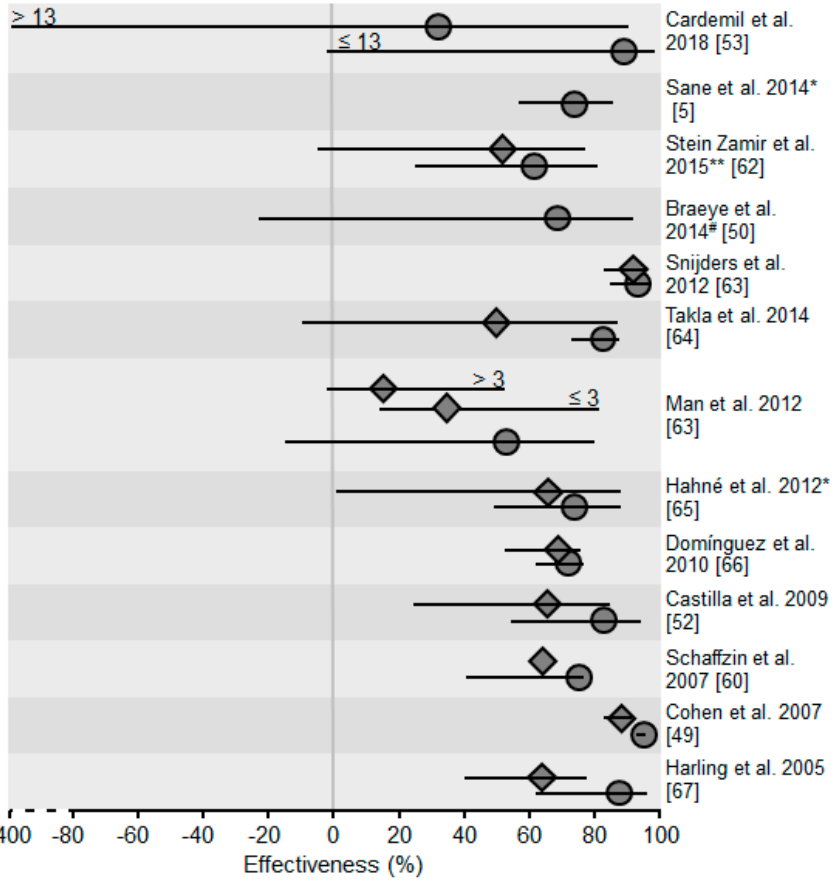
Figure 2. Vaccination effectiveness (%) after MMR-vaccination in published analyses. Studies were obtained by performing a “Pubmed” request [42] using the search terms “mumps” and “vaccination effectiveness” and “outbreak”. Data were accessed on 29 March 2018. Rhombuses: Effectiveness after 1 MMR dose. Circles: Effectiveness after 2 doses. Lines: 95%-Confidence intervalls. >13 = Effectiveness when second vaccine dose was >13 years ago. ≤ 13 = Effectiveness when second vaccine dose was ≤ 13 years ago. * / **: Effectiveness against orchitis * or other complcations **. # : Effectiveness of 2 doses vs. 1 dose. ≤ 3 = Effectiveness when first vaccine dose was ≤ 3 years ago. >3 = Effectiveness when first vaccine dose was >3 years ago.